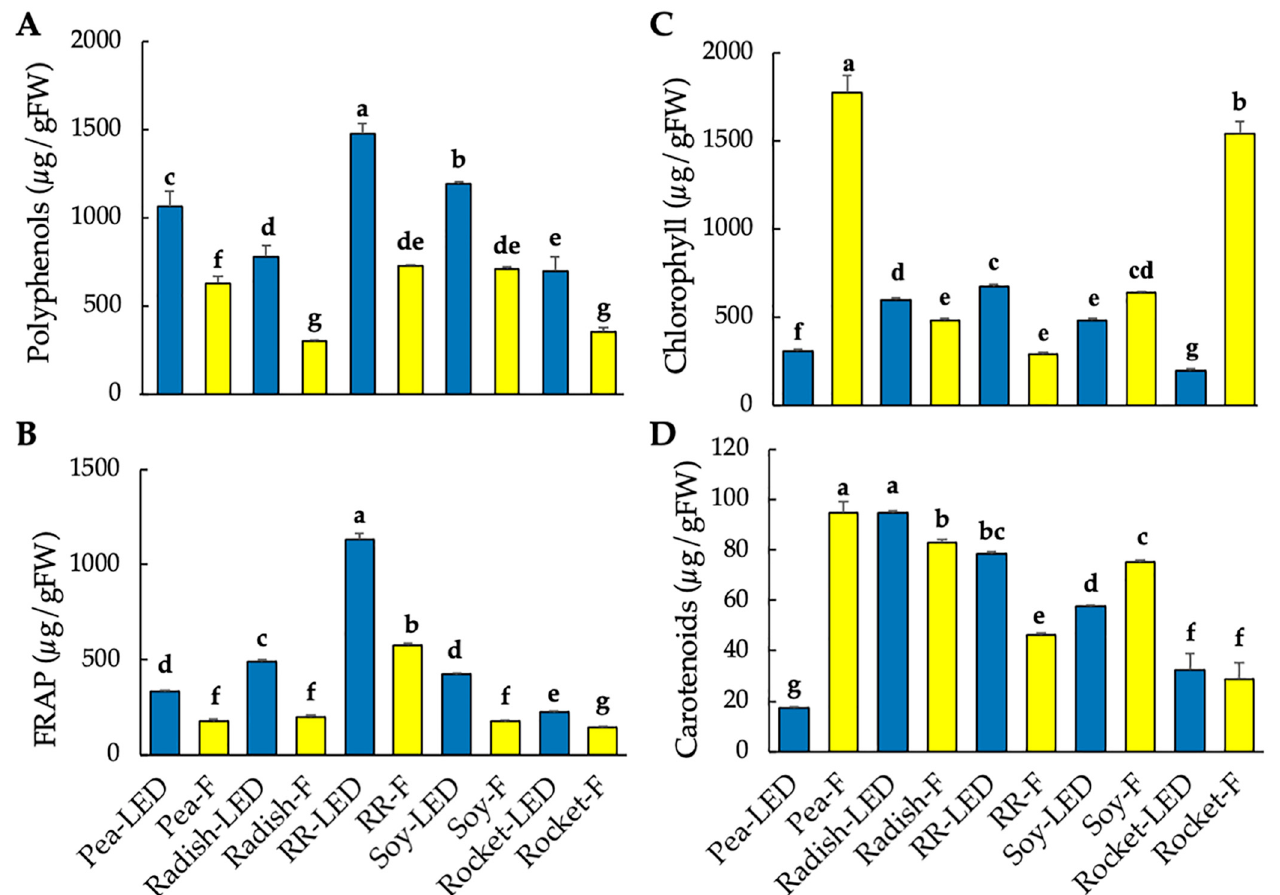
Figure 3. Polyphenol content ( A ), FRAP ( B ), chlorophyll (( C ), sum total of chlorophyll a and b), and carotenoid ( D ) content of green pea, radish, Red Rambo (RR), soybean (soy), and rocket microgreens, cultivated under LED and fluorescent (F) lighting for 10 days. The different lowercase letters (a–g) in each graph denotes significant differences between the microgreen species under different lighting at p < 0.05, as determined from a one-way ANOVA. Table 3. Significance levels of phytochemicals and FRAP for Species, Lighting, and Species × Lighting at 10 days. Polyphenols FRAP Chlorophyll Carotenoids Species (descending order)